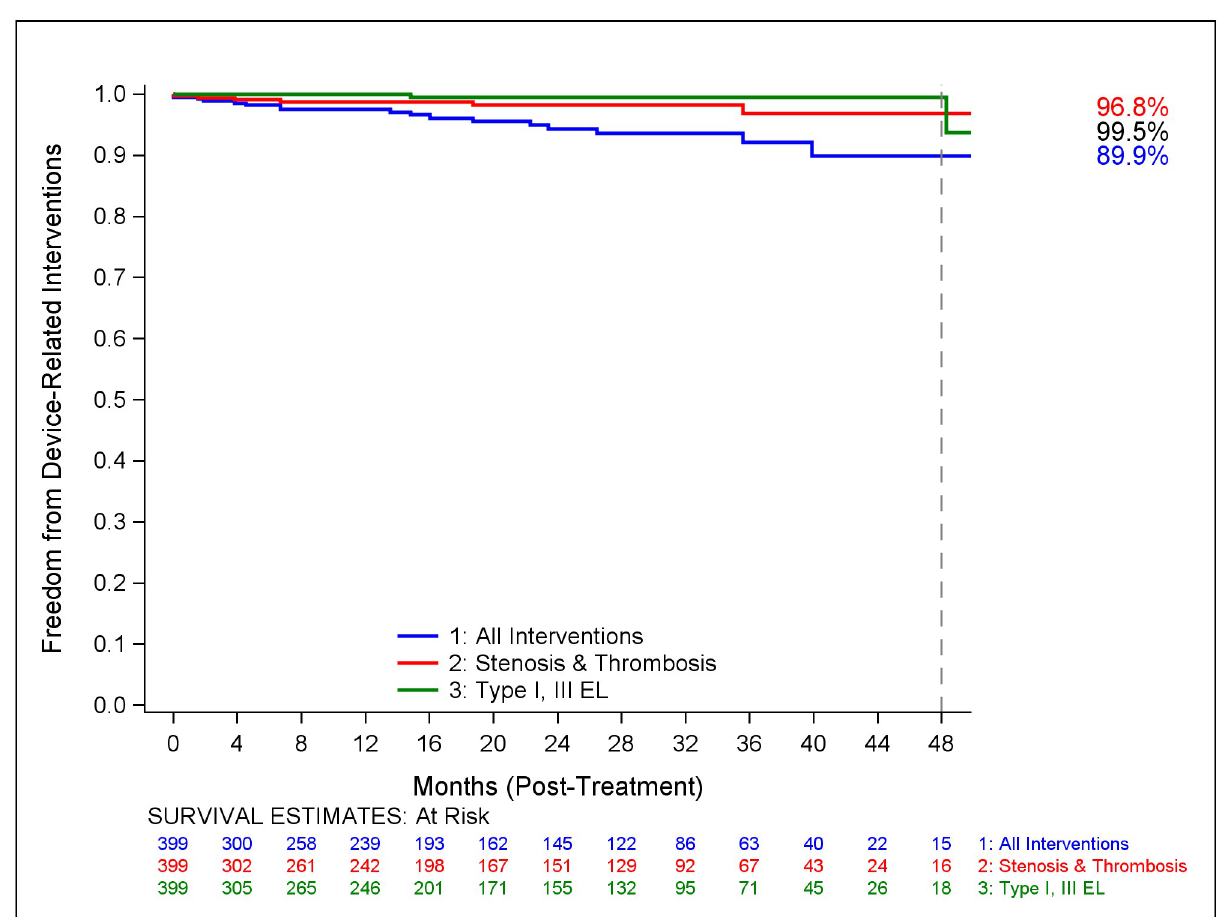
Fig 4. Freedom from device-related interventions. Kaplan-Meier curve illustrating freedom from all device related reintervention including (Fig 3) and excluding interventions (Fig 4) for Type II endoleaks. Freedom from reintervention for endoleaks Types I/III and for graft stenosis / occlusion have been defined separately. Numbers of patients at risk are presented on the x axis.